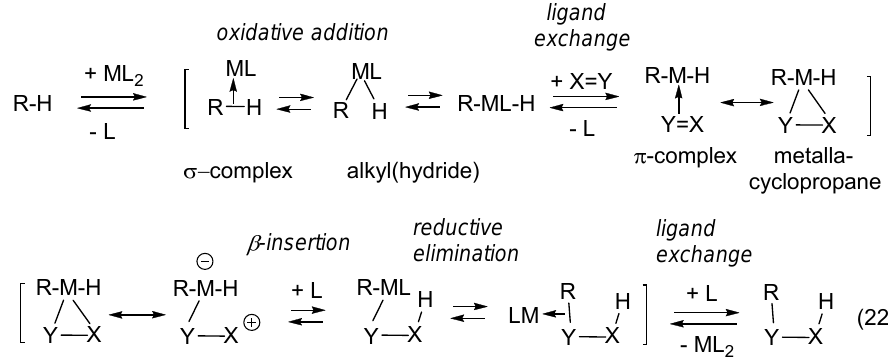
Scheme 4. Transition metal-catalyzed hydrocarbation of unsaturated